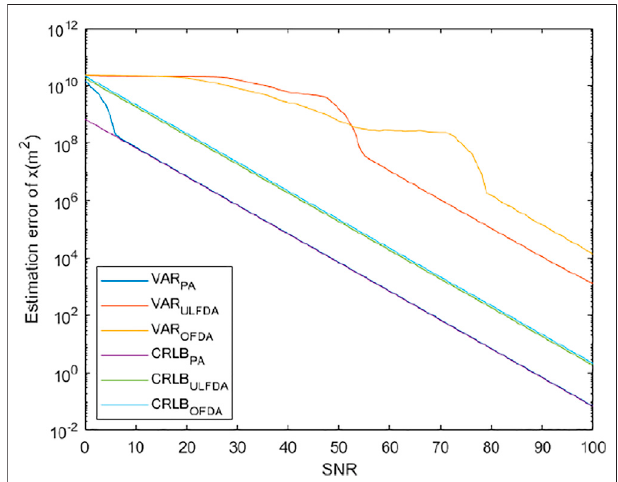
FIGURE 9 | The variation of location error with